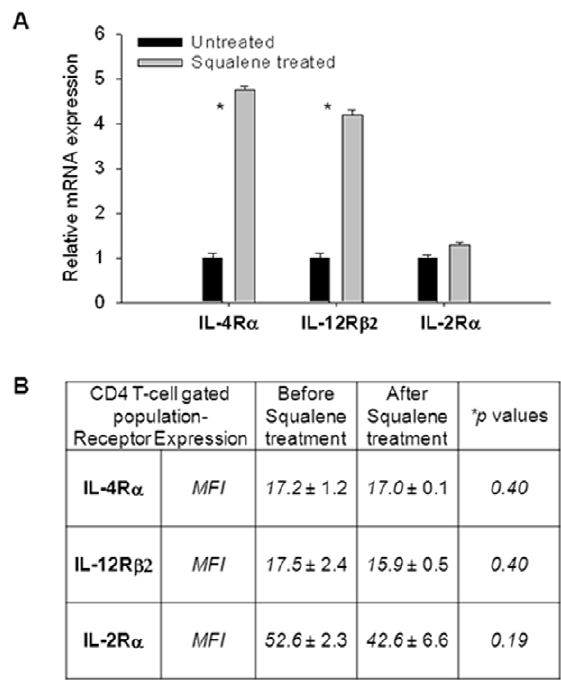
Figure 5. Alteration in cytokine receptors mRNA expression after squalene enrichment of membrane cholesterol in resting lymphocytes. ( A ) Quantitative real-time RT-PCR of IL-4R a , IL-12R b 2, and IL-2R a mRNA extracted from peripheral blood lymphocytes of individual F1 mice (n=5/group) analyzed before squalene treatment (dark bars) and 7 days after squalene injection (180 m g/mouse) (light bars). Y axis indicates the mean fold increase in mRNA expression level relative to the endogenous 18S rRNA expression level (control 6 SD). Shown are two combined separate experiments (* p values , 0.05). ( B ) Aliquots samples in panel A were stained with CD4-FITC conjugate, co- stained either with IL-4R a -PE or IL-12R b 2-PE or IL-2R a -PE conjugates, and analyzed by FACS at the single-cell level for the surface IL-Rs expression level based on MFI measurements. Shown are the IL-Rs MFI values 6 SD measured in individual mice before and after squalene treatment. Of note, no significant changes occurred in the IL-Rs expression on cell surface after squalene treatment (* p values .